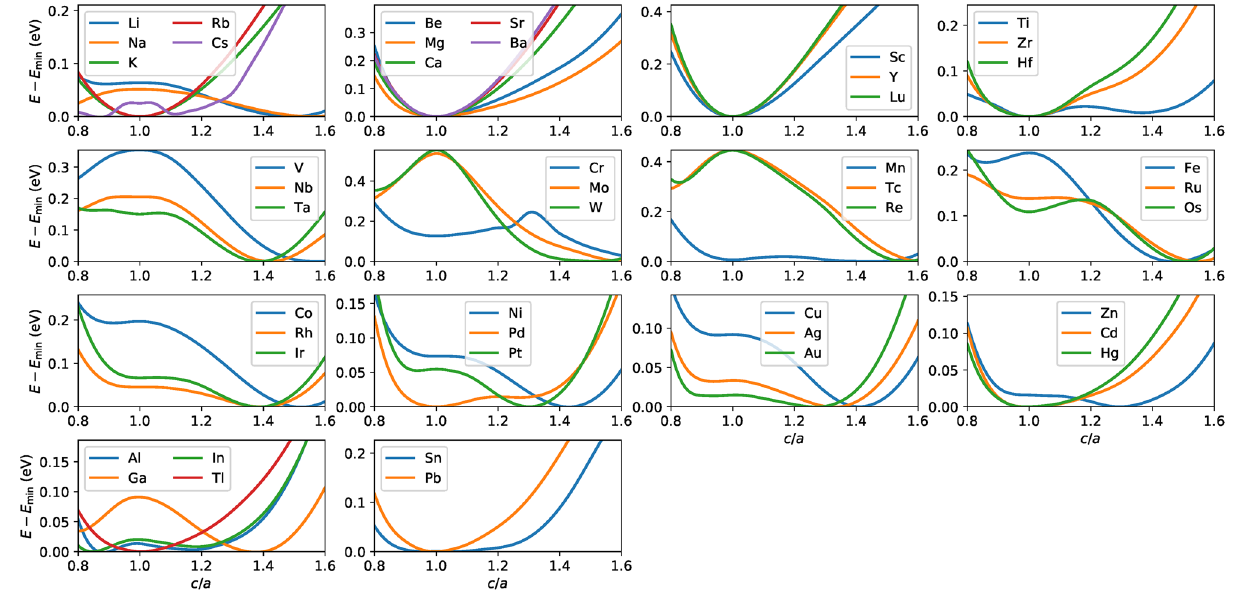
Figure 5. The total energy per a cell as a function of c / a (the tetragonal path) for Cu X .